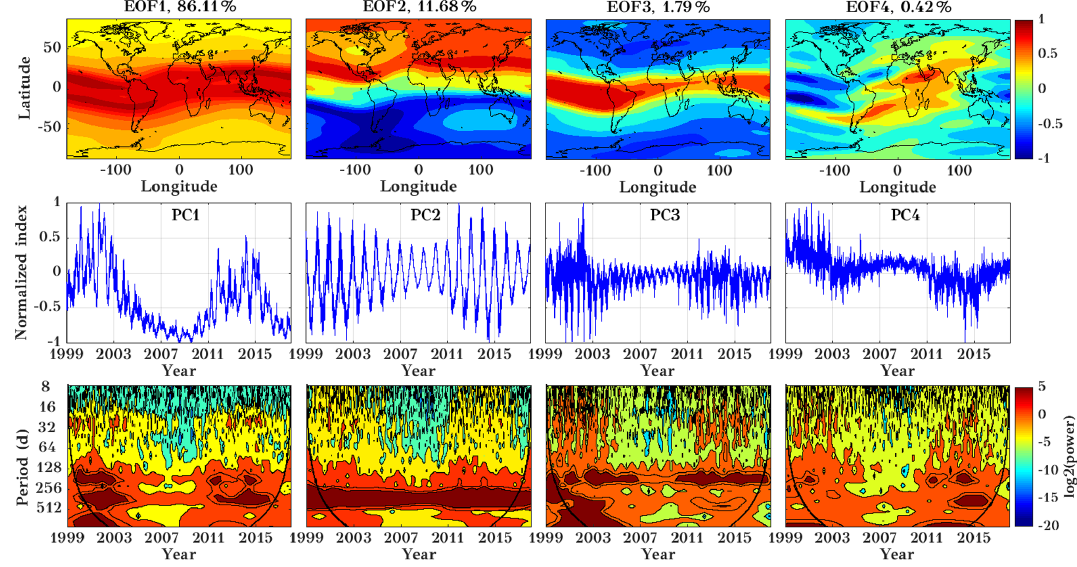
Figure 11. The first four EOFs (top row) of normalized TEC during the years 1999 to 2017, corresponding principal components (middle row), and their corresponding wavelet transform (bottom row, wavelet power in log2 scale). Please note that EOFs are